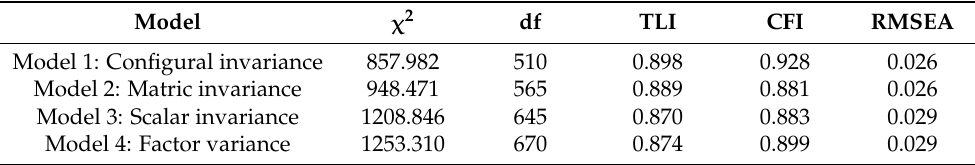
Table 3. Results for goodness-of-fit for identity verification. Model χ 2 df TLI CFI RMSEA